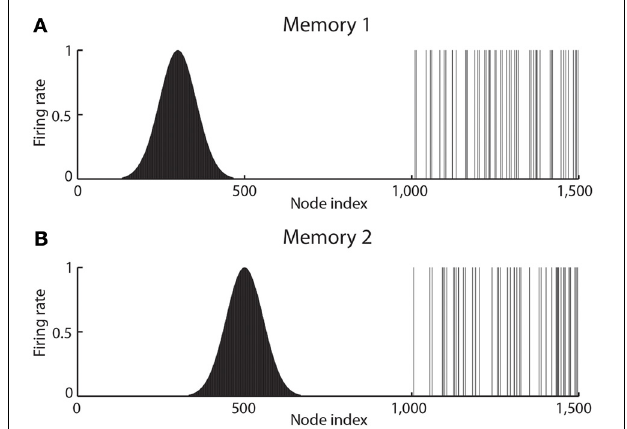
FIGURE 3 | The types of firing patterns stored in continuous attractor networks are illustrated for the patterns present on neurons 1–1000 for Memory 1 (when the firing is that produced when the spatial state represented is that for location 300), and for Memory 2 (when the firing is that produced when the spatial state represented is that for location 500). The continuous nature of the spatial representation results from the fact that each neuron has a Gaussian firing rate that peaks at its optimal location. This particular mixed network also contains discrete representations that consist of discrete subsets of active binary firing rate neurons in the range 1001–1500. The firing of these latter neurons can be thought of as representing the discrete events that occur at the location. Continuous attractor networks by definition contain only continuous representations, but this particular network can store mixed continuous and discrete representations, and is illustrated to show the difference of the firing patterns normally stored in separate continuous attractor and discrete attractor networks. For this particular mixed network, during learning, Memory 1 is stored in the synaptic weights (A) , then Memory 2 (B) , etc., and each memory contains part that is continuously distributed to represent physical space, and part that represents a discrete event or